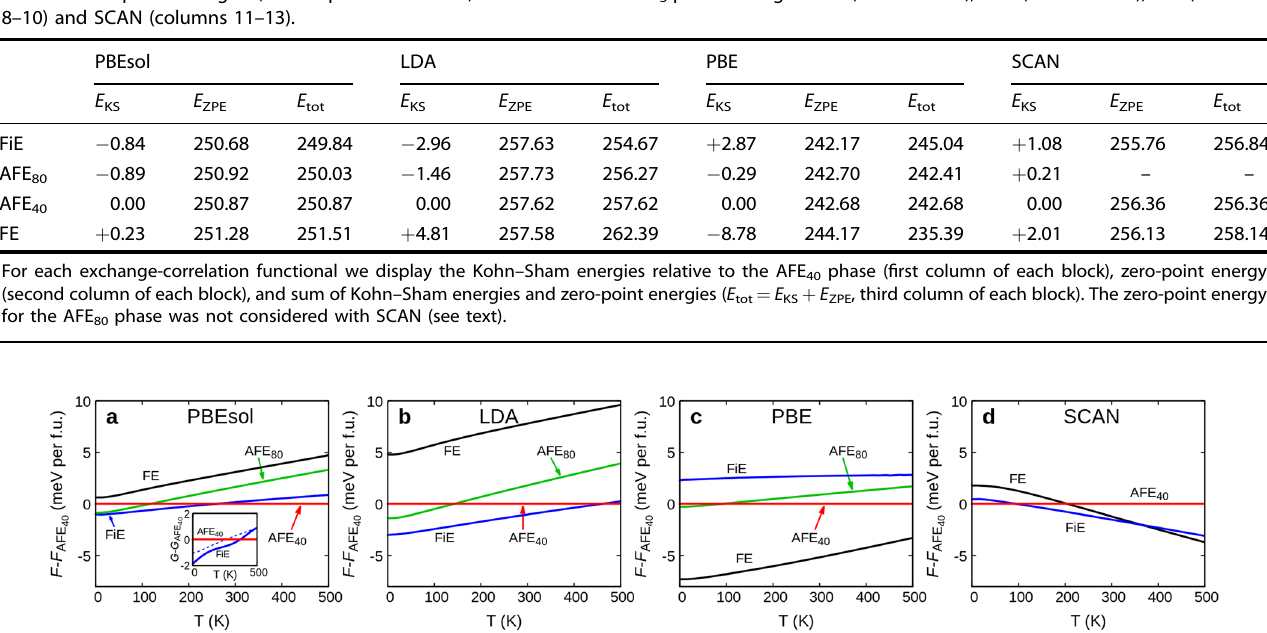
Fig. 5 Free energies of the studied PbZrO 3 phases as a function of temperature. Free energy differences to the AFE 40 phase (red) as a function of temperature for the FiE (blue), AFE 80 (green) and FE (black) phases of PbZrO 3 are shown in panels a , b , c and d for PBEsol, LDA, PBE and SCAN, respectively. The inset in a shows the result for the FiE and AFE 40 states when accounting for thermal expansion (i.e., zero pressure conditions) as obtained with PBEsol. The dashed line in the inset corresponds to the free energy of the FiE without considering the thermal